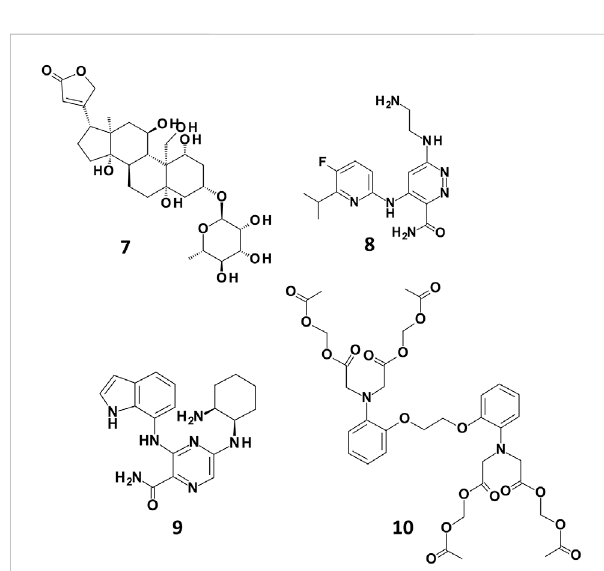
FIGURE 4 Chemical structures of some examples of compounds correctly predicted by one of the SB BP models (compounds 7 , 8 and 9 ) and by all the three SB BP classi fi ers (compound 10